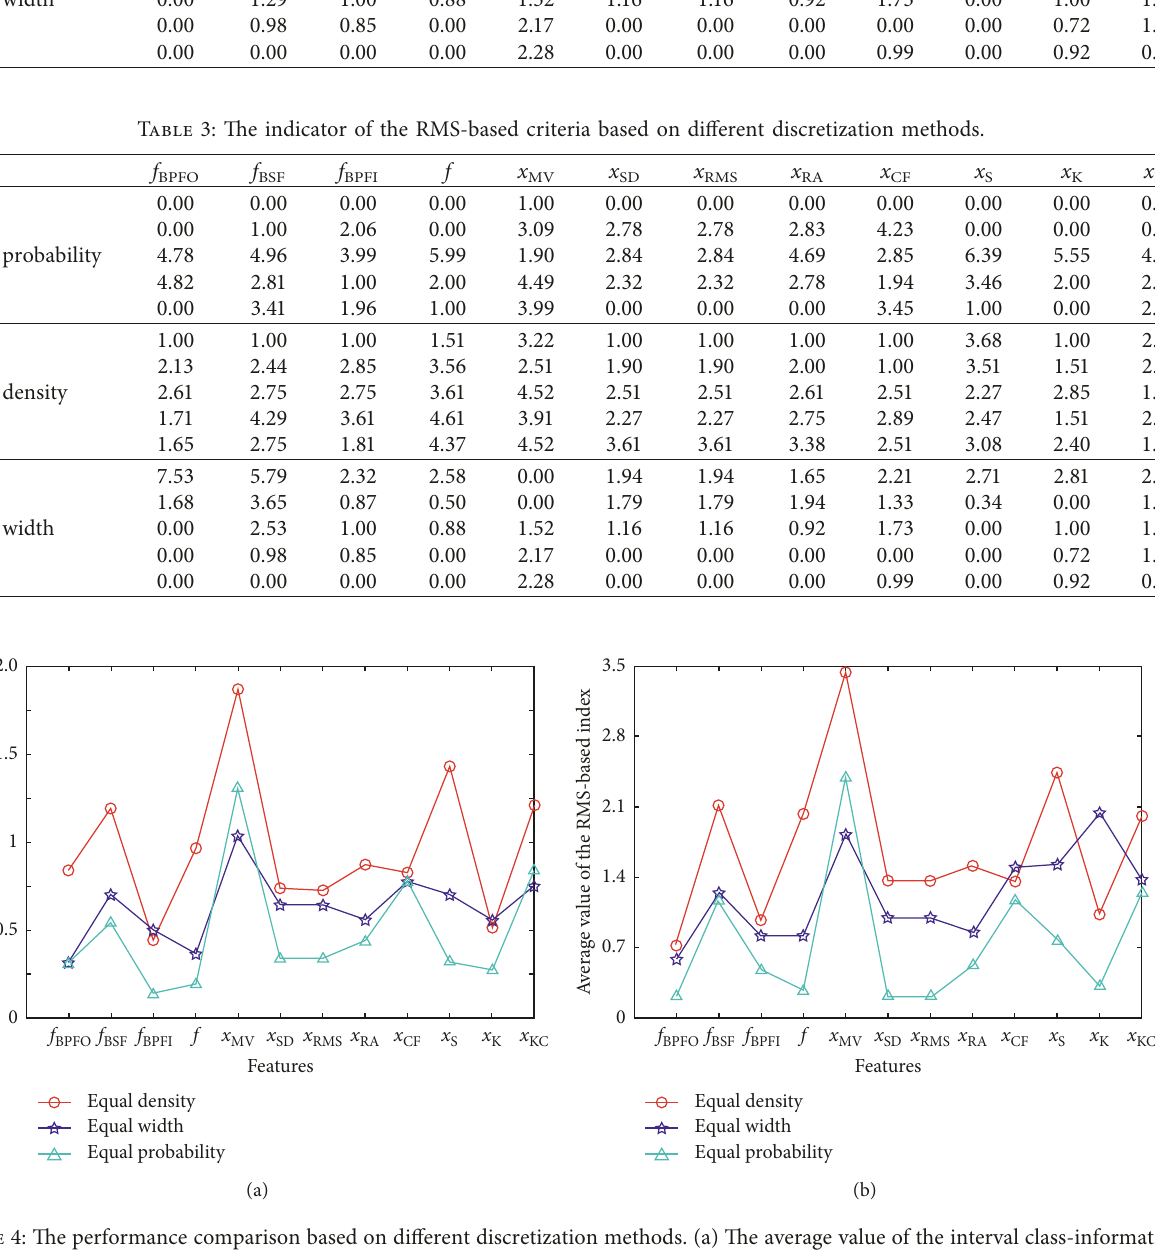
Figure 4: The performance comparison based on different discretization methods. (a) The average value of the interval class-information entropy. (b) The average value of the RMS-based